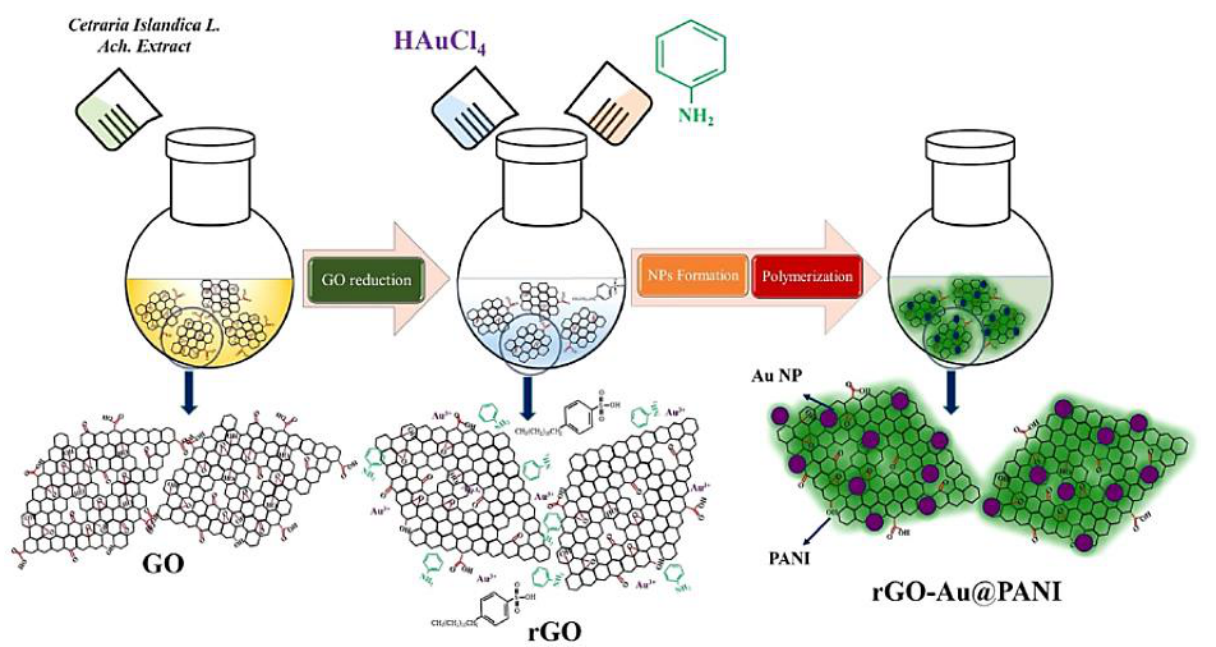
Figure 5. Schematic of green rGO-Au@PANI nanocomposite fabrication [86]. Reproduced with permission from Elsevier. GO = graphene oxide; rGO = reduced graphene oxide; rGO-Au@PANI = reduced graphene oxide-gold nanoparticle@polyaniline. Reproduced with permission from Elsevier.